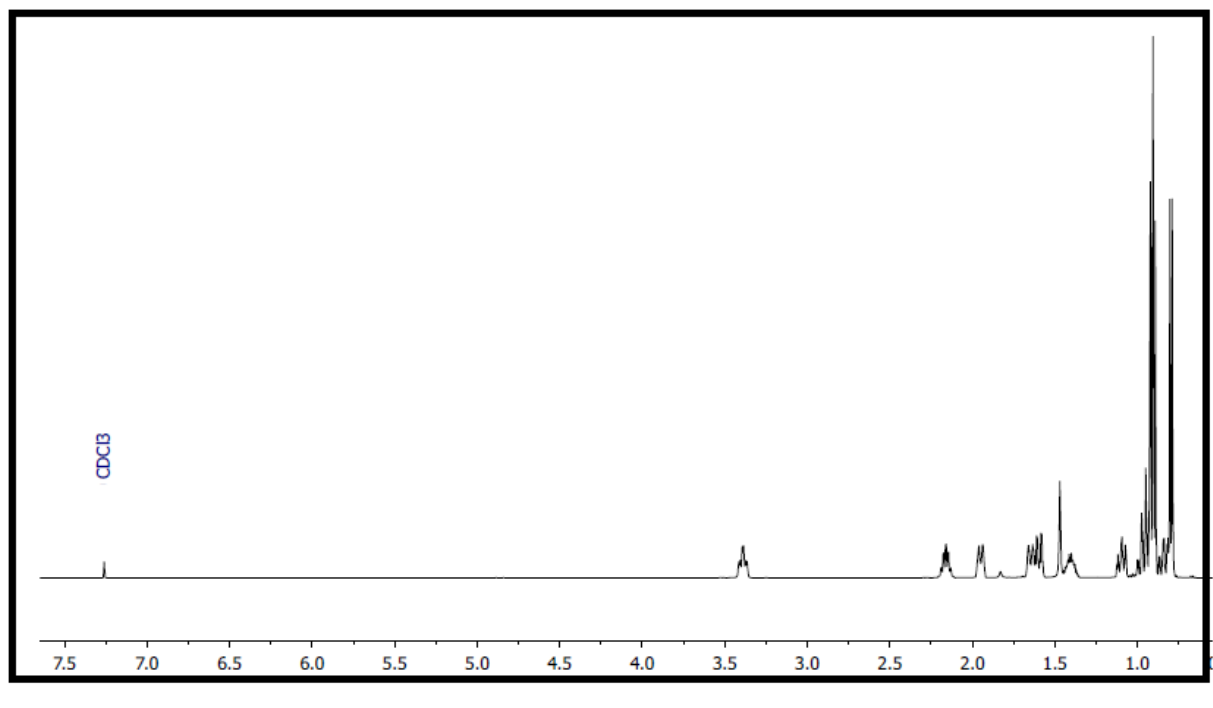
Figure 5: 1 H-NMR spectrum of menthol.